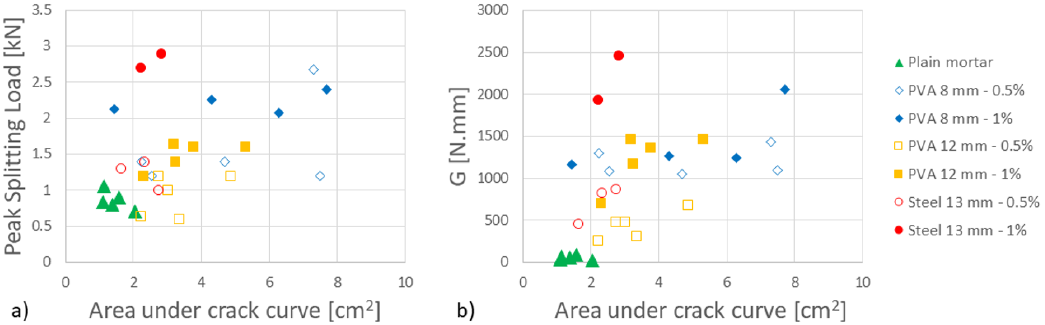
Figure 7. ( a ) Peak splitting load and ( b ) post-peak fracture energy versus crack deviation with respect to the midline